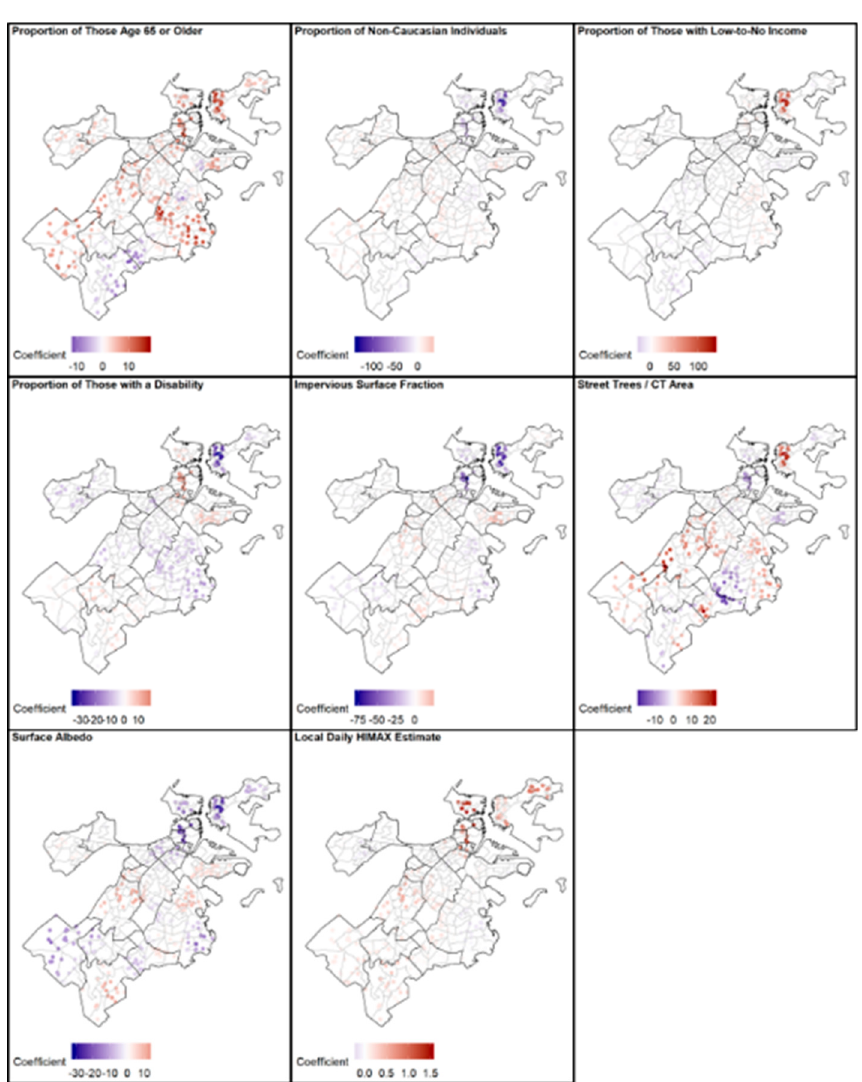
Figure 2. The local GWR coefficients, with blue colors representing negative coefficients and red colors representing positive coefficients, in relation to the daily at-home death rate on days where HI MAX ≥ 86 °F at Logan International Airport. CT denotes census tract.